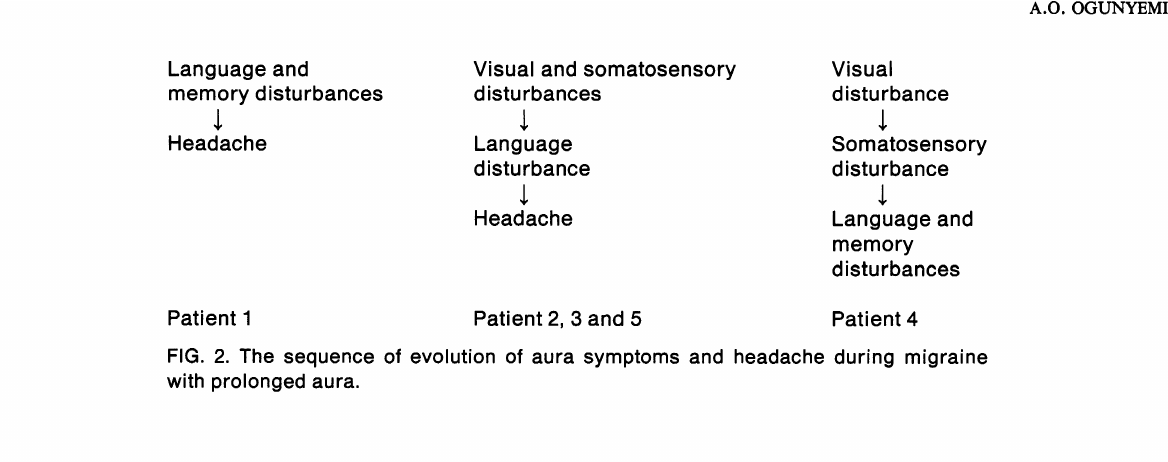
FIG. 2. The sequence of evolution of aura symptoms and headache during migraine with prolonged